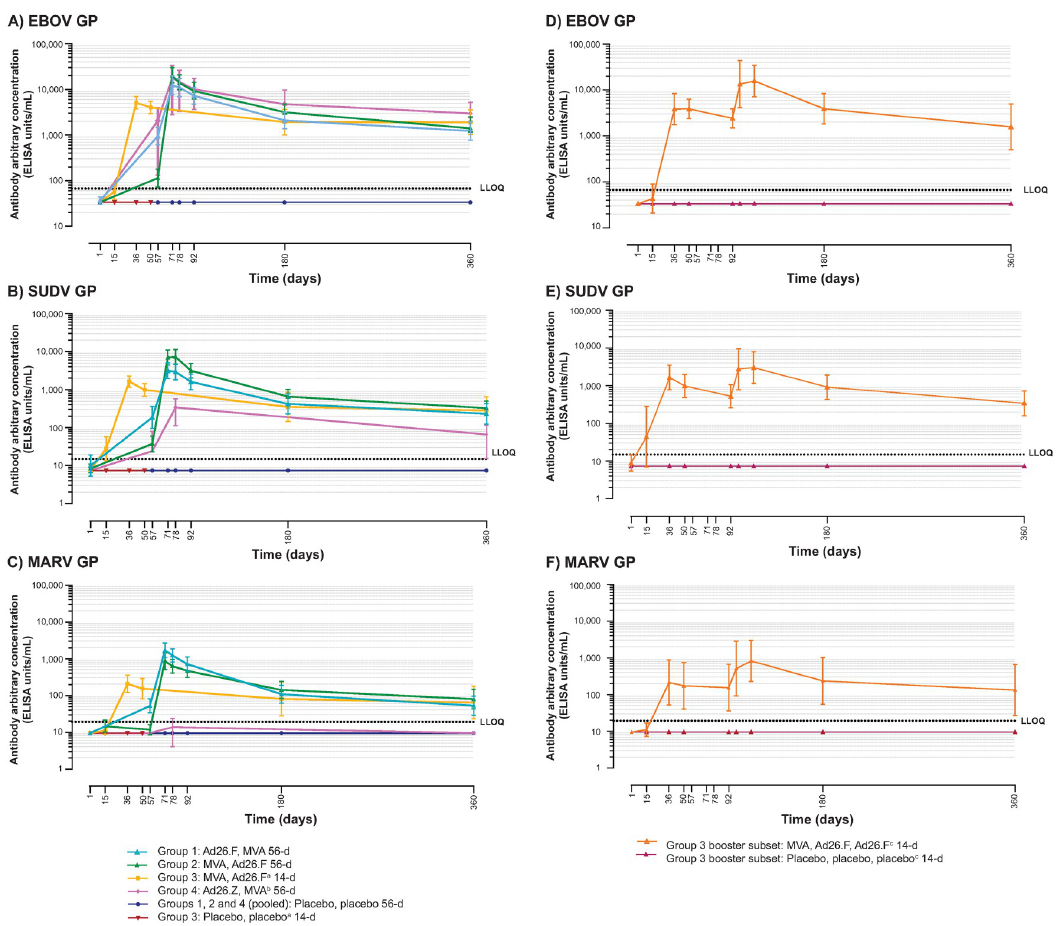
Fig 2. GP-specific binding antibody responses (ELISA units/mL): Regimen profiles (geometric means with 95% CIs); immunogenicity analysis set. Ad26.F = Ad26.Filo; Ad26.Z = Ad26.ZEBOV; CIs = confidence intervals; EBOV = Zaire ebolavirus ; ELISA = enzyme-linked immunosorbent assay; GP = glycoprotein; Inf U = infectious units; LLOQ = lower limit of quantification; MARV = Marburg virus ; MVA = MVA-BN-Filo; SUDV = Sudan ebolavirus . a Includes all Group 3 participants up to and including the Day 50 time point, after which point only Group 3 participants who did not receive a third dose of vaccine/placebo on Day 92 are included. b MVA-BN-Filo at a dose 1x10 8 Inf U. c All time points include only Group 3 participants who received three doses of